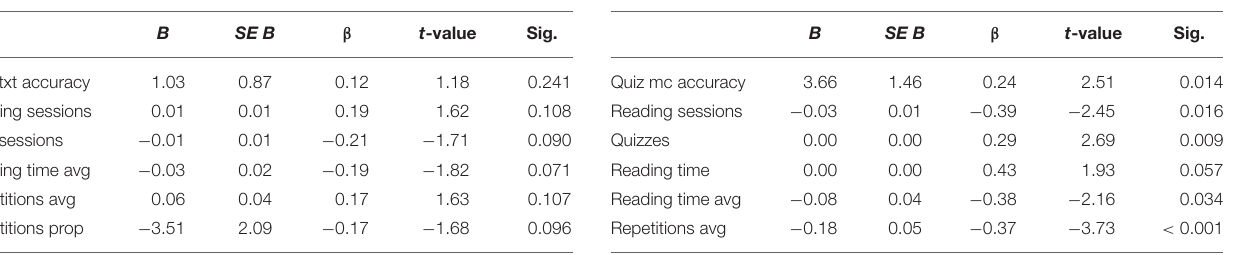
TABLE 3 | Regression coefficients with Block span as the dependent variable. TABLE 4 | Regression coefficients with Digit span as the dependent